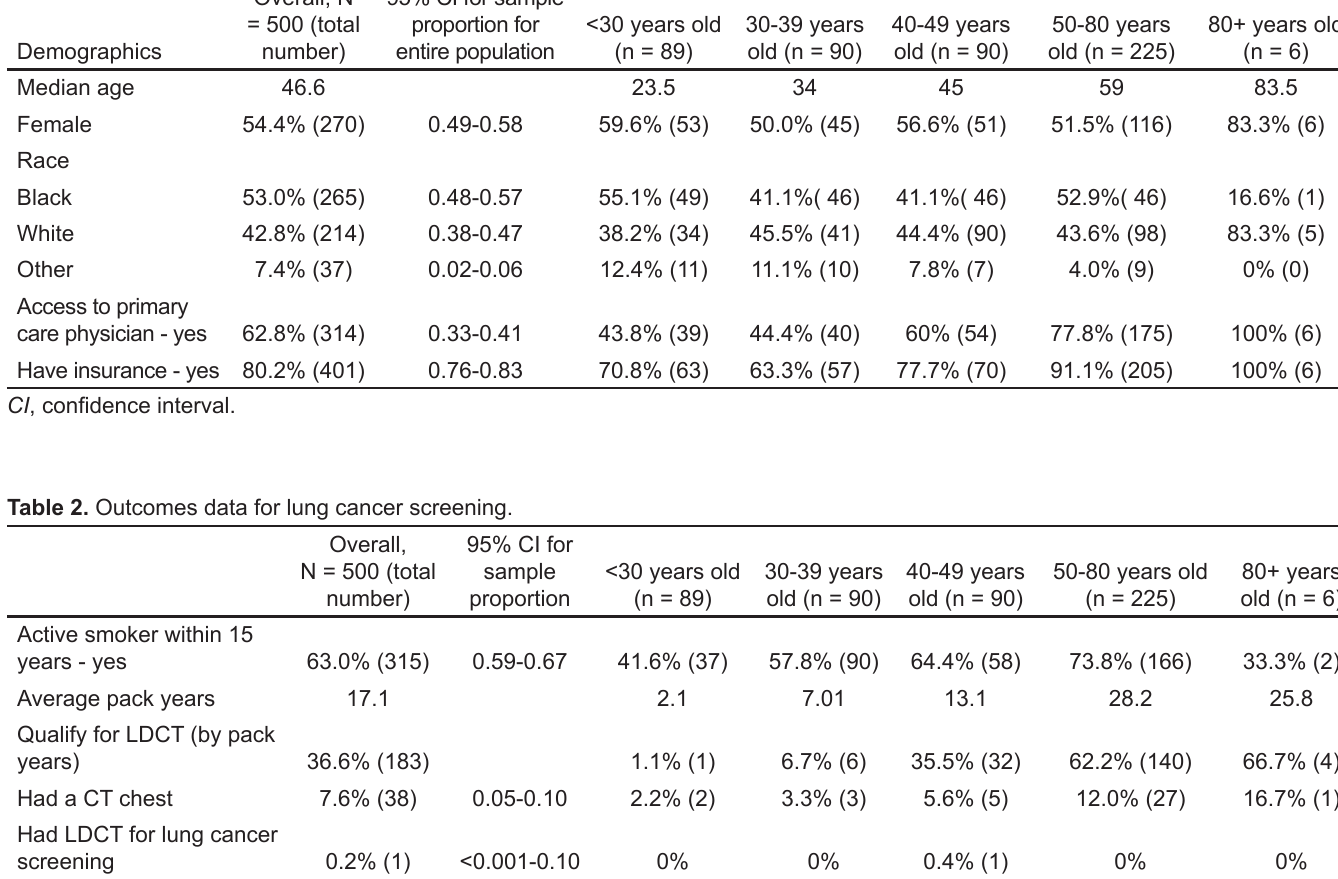
Table 1. Demographics and characteristics for the study population.